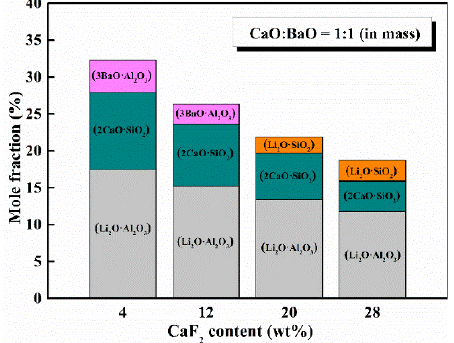
Figure 7. Mole fraction of the top three complex molecules as a function of CaF 2 content.